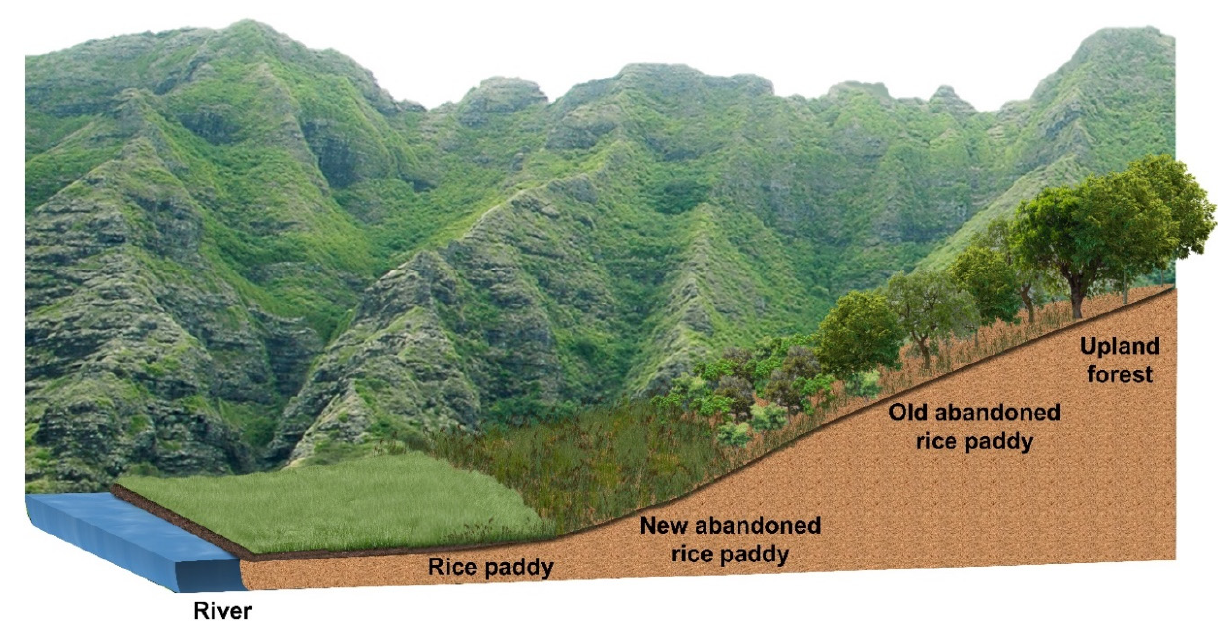
Figure 2. A schematic diagram showing the spatial distribution of the abandoned rice paddies and their different successional stages. Abandonment of rice paddy began in an inaccessible place away from the residential area, and the successional stage tended to be determined by the distance from residential area.